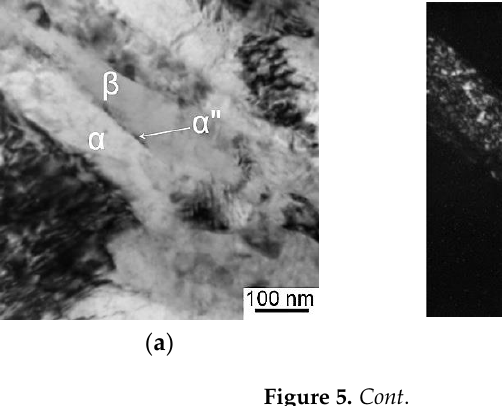
Figure 4. TEM bright- ( a , b ) and dark-field ( c ) images and an associated SAED pattern with an indexing scheme ( d ) of the microstructure of the Ti-6Al-4V samples subjected to UIT. The TEM micrographs were obtained at a depth of 5 µ m below the treated surface. The dark-field micrograph was obtained with the 011 α -Ti reflection. The microstructure of the lower layer located at a depth of 10 µm below the treated surface consists of α grains with an intragranular band structure (Figure 5). The average width of the elongated subgrains is equal to 100 nm. It is worth noting that the interlayers of the retained β phase are observed between α subgrains (Figure 5d). Moreover, thin platelets (5–10 nm thick) of the orthorhombic (α”) martensite are observed at the boundaries between the α and β phases (Figure 5c).